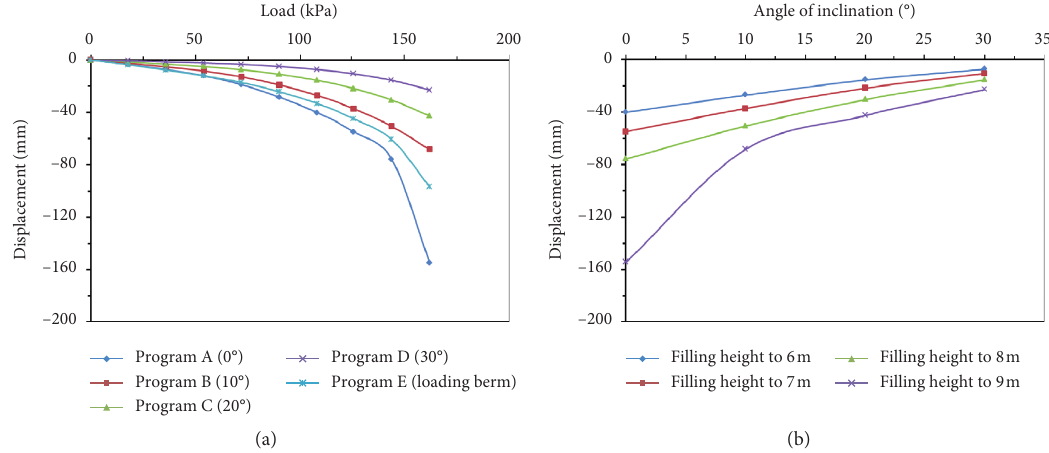
Figure 10: Variations of maximum displacement. (a) Change with loads and (b) change with inclination angles.